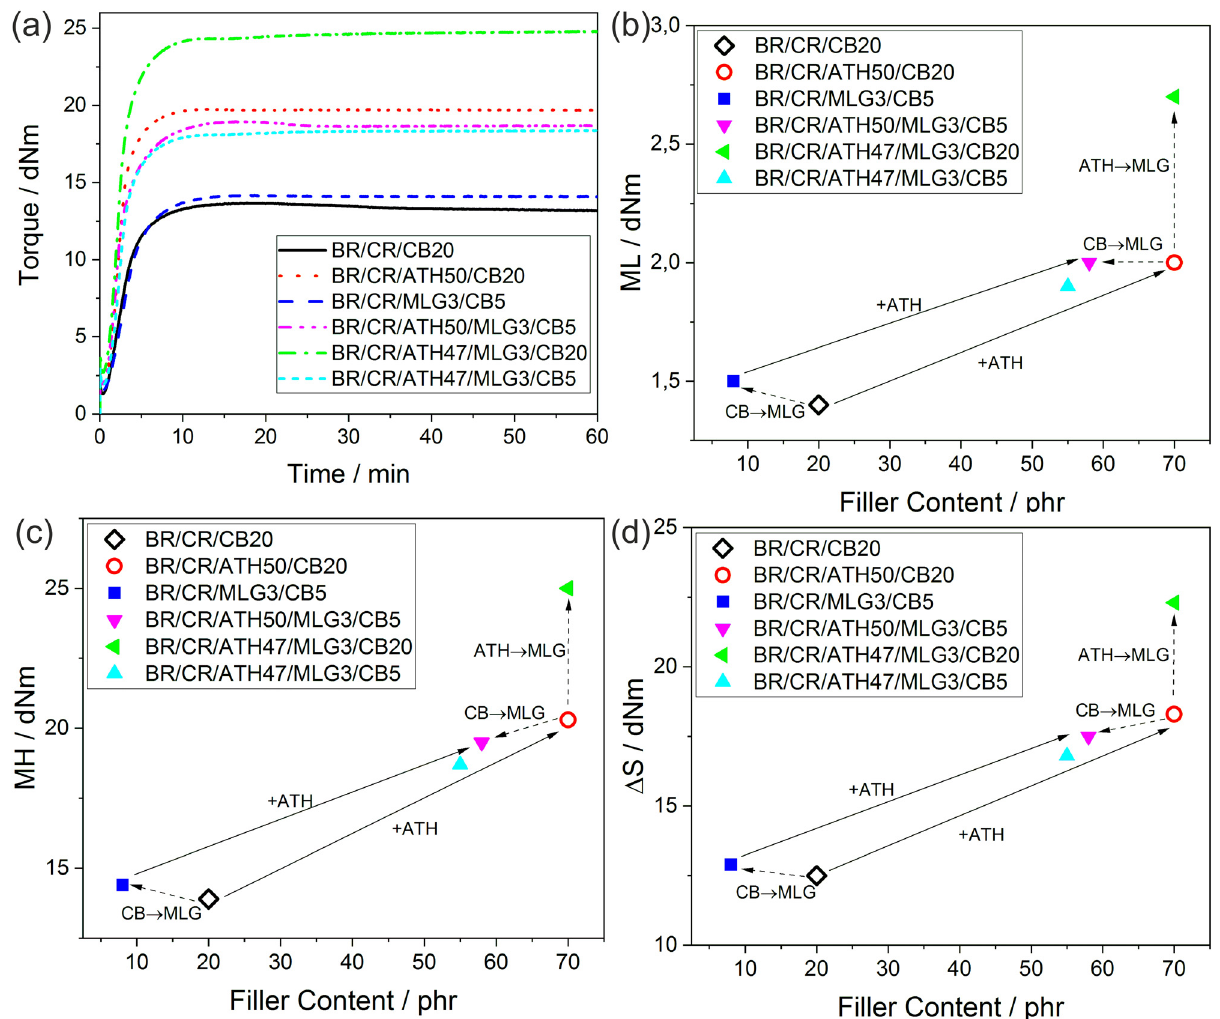
Figure 5: Curing properties of BR/CR composites: ( a ) curing curves, i.e., torque over time, ( b ) minimum of torque ( ML ) vs fi ller content of composites, ( c ) maximum of torque ( MH ) vs fi ller content, and ( d ) di ff erence between maximum and minimum of torque ( Δ S ) vs fi ller content. For ( b ) , ( c ) , and ( d ) : solid line is addition of 50 phr ATH; dashed line is replacement of 15 phr CB with 3 phr MLG, or 3 phr ATH with 3 phr MLG, respectively.